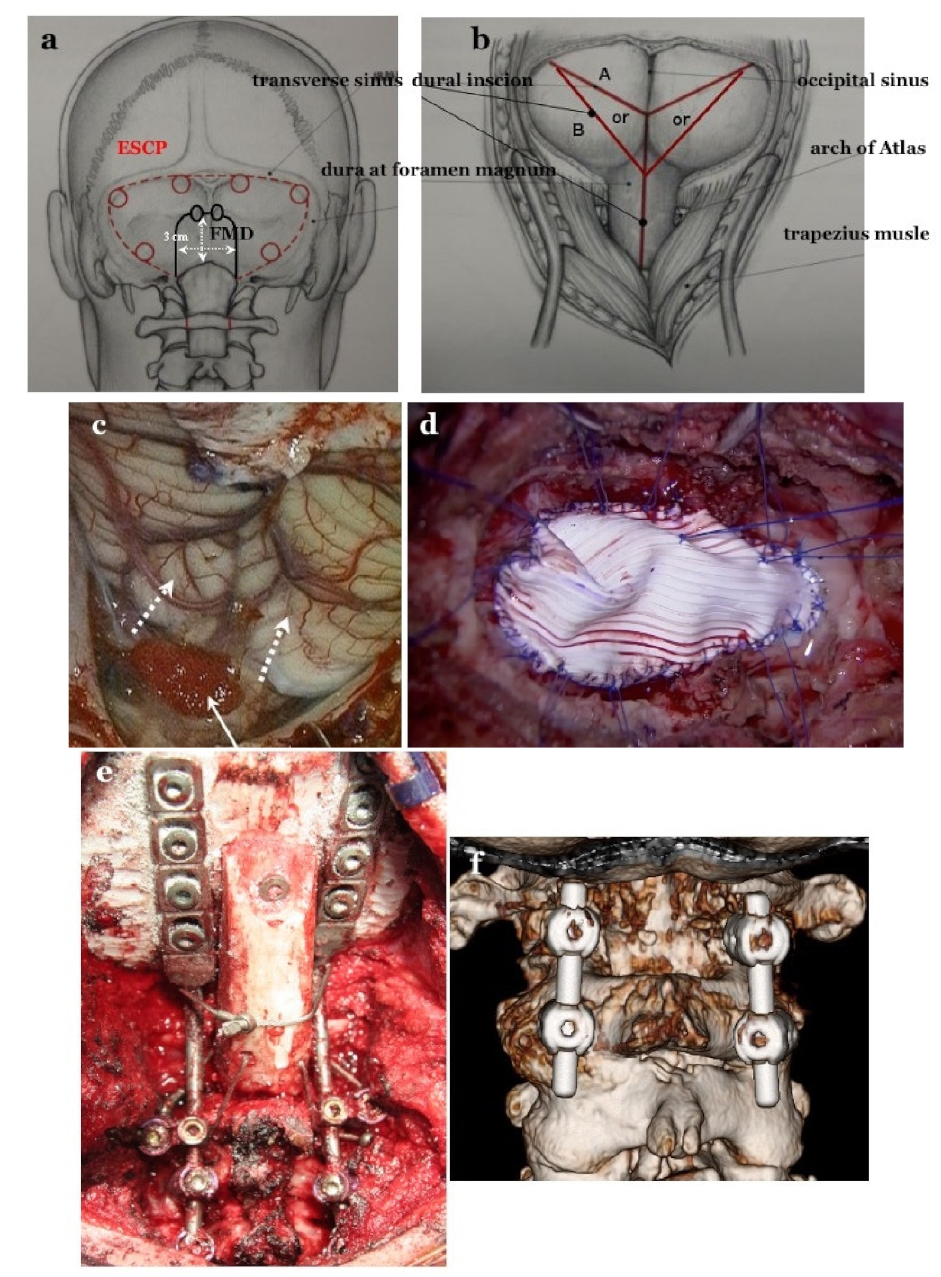
Figure 2. Craniotomy of FMD and ESCP, and dural incision after opening the dura matter and dural plasty. ( a ): For expansive suboccipital cranioplasty (ESCP), craniotomy is performed along the transverse and sigmoid sinuses. The foramen magnum (FMD) craniotomy is 2–3 cm in size. In FMD, the subocciptal muscle group is preserved. ( b ): Dural incision in both operations. ( c ): Opening the dura mater while preserving the arachnoid membrane. Tonsils move up after achieving appropriate decompression (white dotted arrows). Preventing blood from entering into the subarachnoid space through the pinhole by placing a sponge (white arrow) ( d ): Dural plasty by tightly applying Gore Tex ® (Gore Inc., Newark, DE, USA) sheet water and applying 6–8 threads on bilateral sutures and midline for tenting. OCF and C1/2 FIX. ( e ): Occipital–cervical fixation (OCF), occipital screws, pedicle screws at bilateral C2, and lateral mass screw at bilateral C3 as anchor screws were connected by rods. ( f ): C1/2 fixation by Goel’s and Harm’s method: pedicle screws at bilateral C2 and lateral mass screws at bilateral C1 as anchor screws were connected by